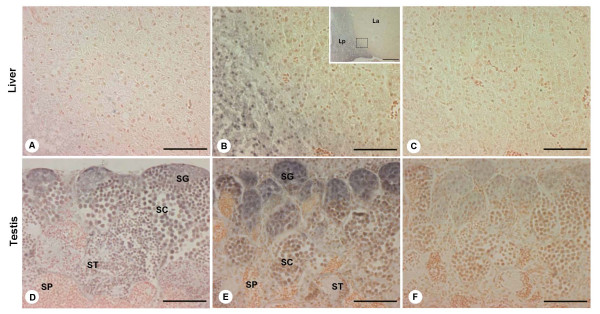
In situ localization of omTERT mRNA in livers (A-C) and testes (D-F) of marine medaka. (A) Liver under normoxia (6.4 mg O2 L-1). Weak expression of omTERT mRNA (blue) is observed in liver parenchyma. (B) Liver exposed to hypoxia (1.8 mg O2 L-1) for 96 h. Induced expression of omTERT mRNA (blue) is evident, particularly at the posterior or caudal region of liver (Lp) as compared to the rostal or anterior region (La) (see insert at low magnification). (C) Adjacent liver section of (B) hybridized with an omTERT sense riboprobe as a negative control. (D) Testis under normoxia (6.4 mg O2 L-1). Expression of omTERT mRNA (blue) is strong in cysts containing spermatogonia (SG) and spermatocyte (SC), moderate in differentiating spermatids (ST) and absent in mature spermatozoa (SP) (red). (E) Testis exposed to hypoxia (1.8 mg O2 L-1) for 96 h. Induction of omTERT mRNA (blue) is conspicuous in spermatogonia (SG) and less prominent in other testicular cells. (F) Adjacent testis section of (E) hybridized with an omTERT sense riboprobe as a negative control. Scale bars = 50 μm, except insert of (b) = 200 μm.